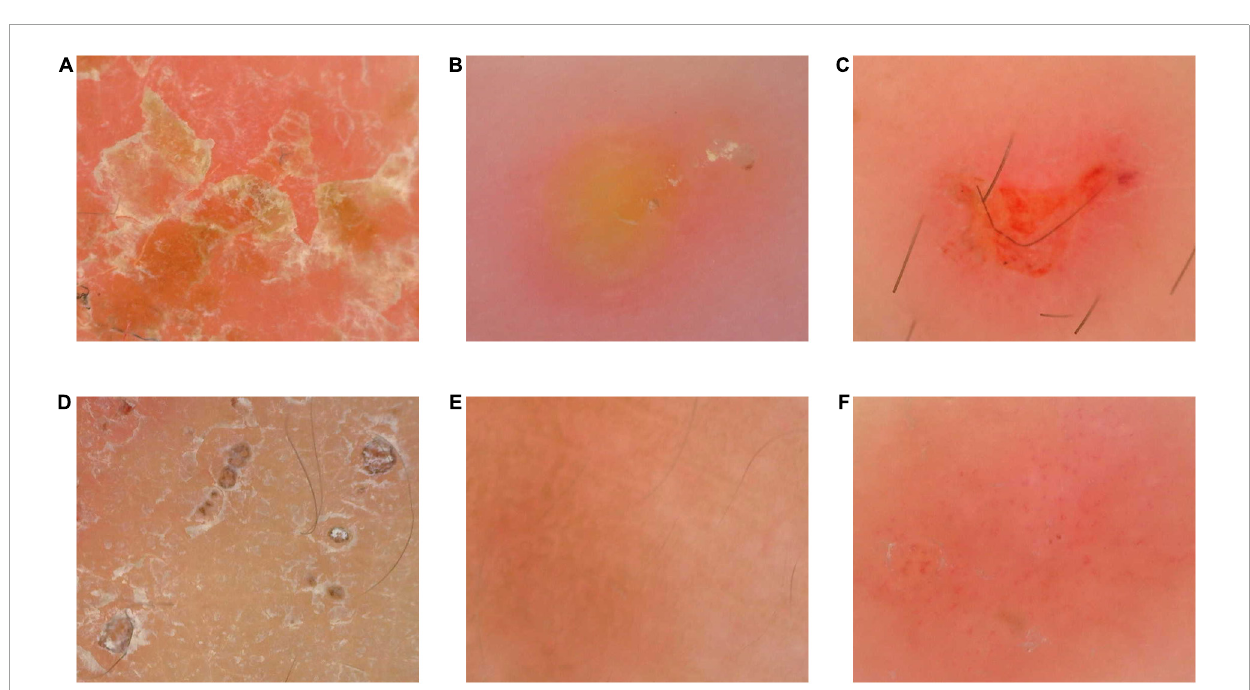
FIGURE3 The non-specific dermoscopic manifestations of scabies. Panel (A) was erythema overlying scales. Panel (B) was pustule. The burrow and dark triangular structure were seen around the edge of pustule. Panel (C) was erosion and exudation. Panel (D) was scratches and blood callus. Panel (E) was pigmentation. Panel (F) was vascular changes. Punctate and globular vessels were focally